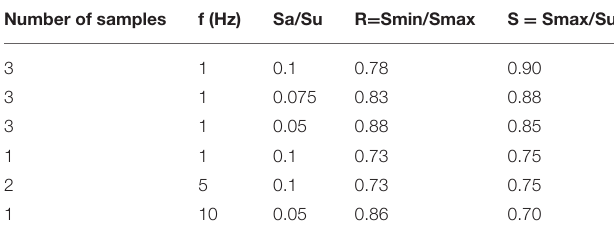
TABLE 1 | Tests results obtained by Ronca et al. (2004). Number of samples